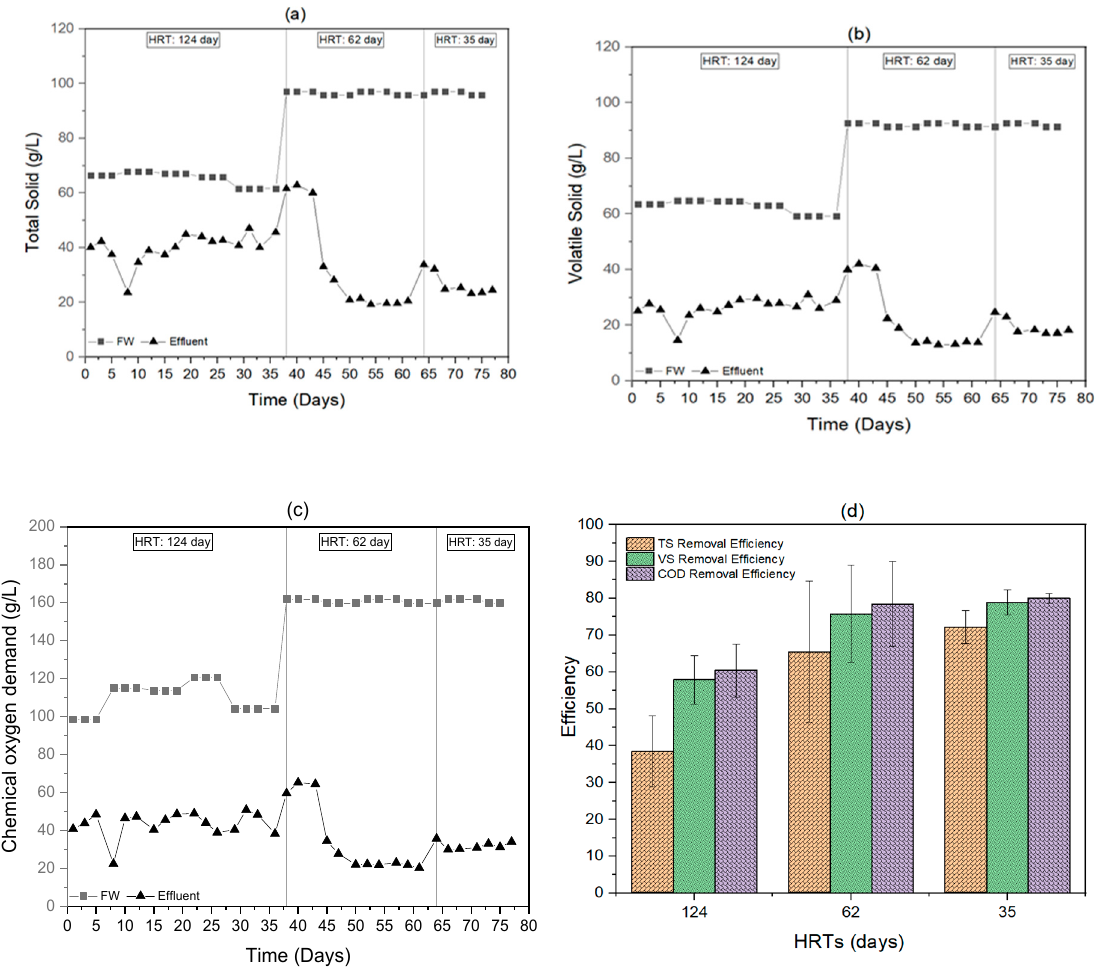
Figure 4. Variations of total solid (TS), volatile solid (VS), and chemical oxygen demand (COD) in different operating stages during anaerobic digestion of food waste. ( a ) TS concentration; ( b ) VS concentration; ( c ) COD concentration; ( d ) average removal efficiency of TS, VS, and COD at different hydraulic retention time (HRT).